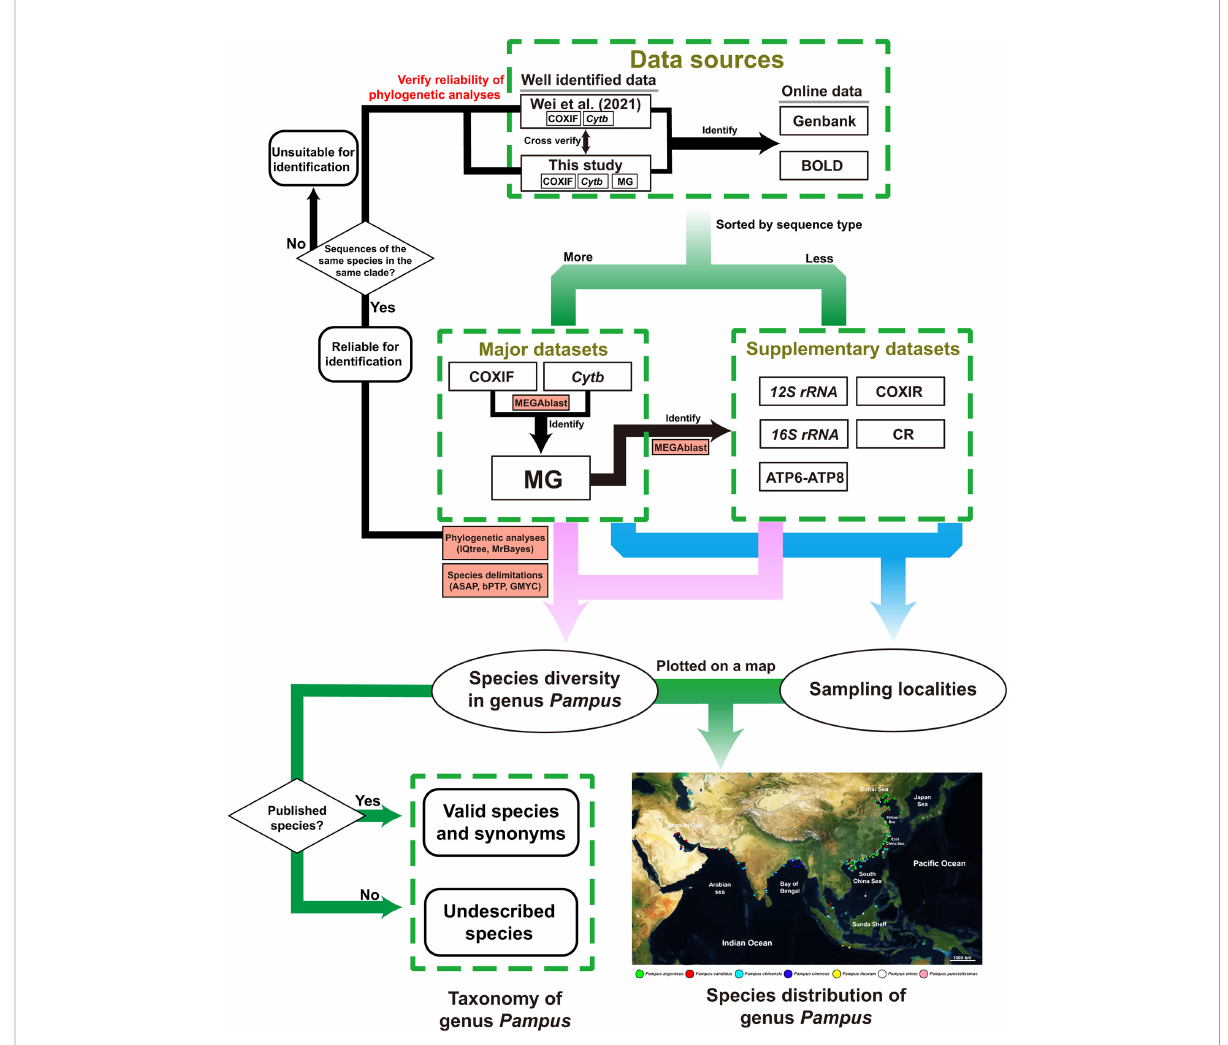
FIGURE 1 A work fl ow for exploring the species diversity and distributions of genus Pampus using the global mitochondrial